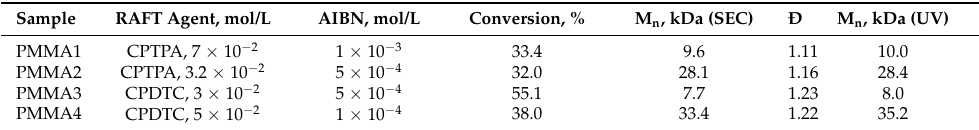
Table 2. Experimental conditions for PMMA synthesis.